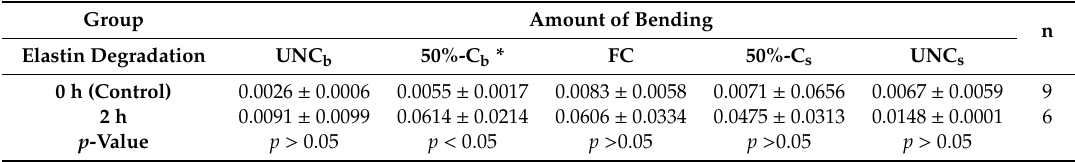
Table 3. Mean ± SEM of bending of samples of min curvature, k min (1 / mm) at five levels of bending for the un-degraded and elastin-degraded porcine aortic valve leaflet specimens after 2 h of elastase exposure (n = 6–9 samples / group). UNC b , 50%-C b , stands for unconstrained and semi-constrained